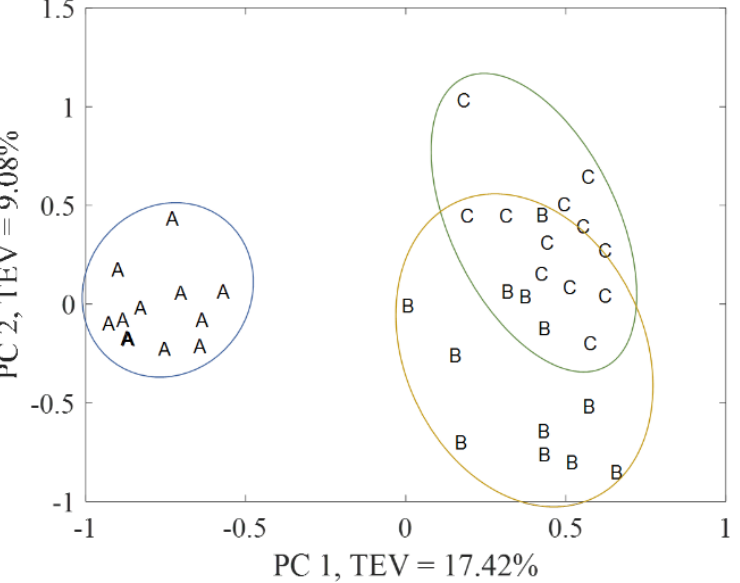
Figure 3. Super score plot of the MB-PCA model combining positive and negative ionization mode blocks. Piglet groups: newborns (A), infants (B), and children (C). TEV = total explained variance.